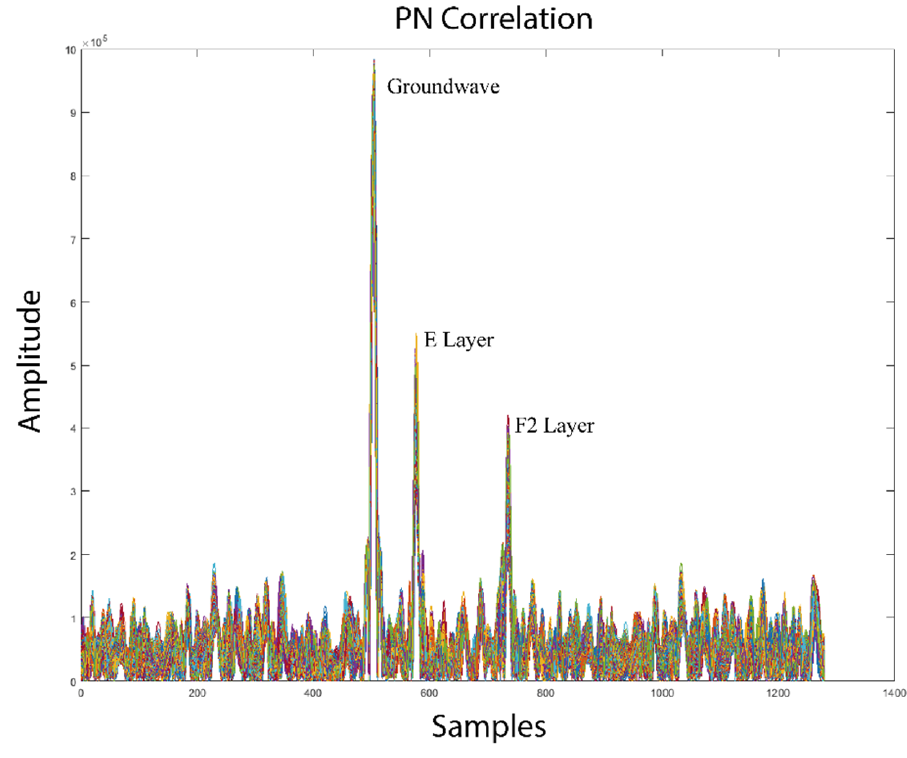
Figure 5. Correlation of 150 PN sequences one above the other.